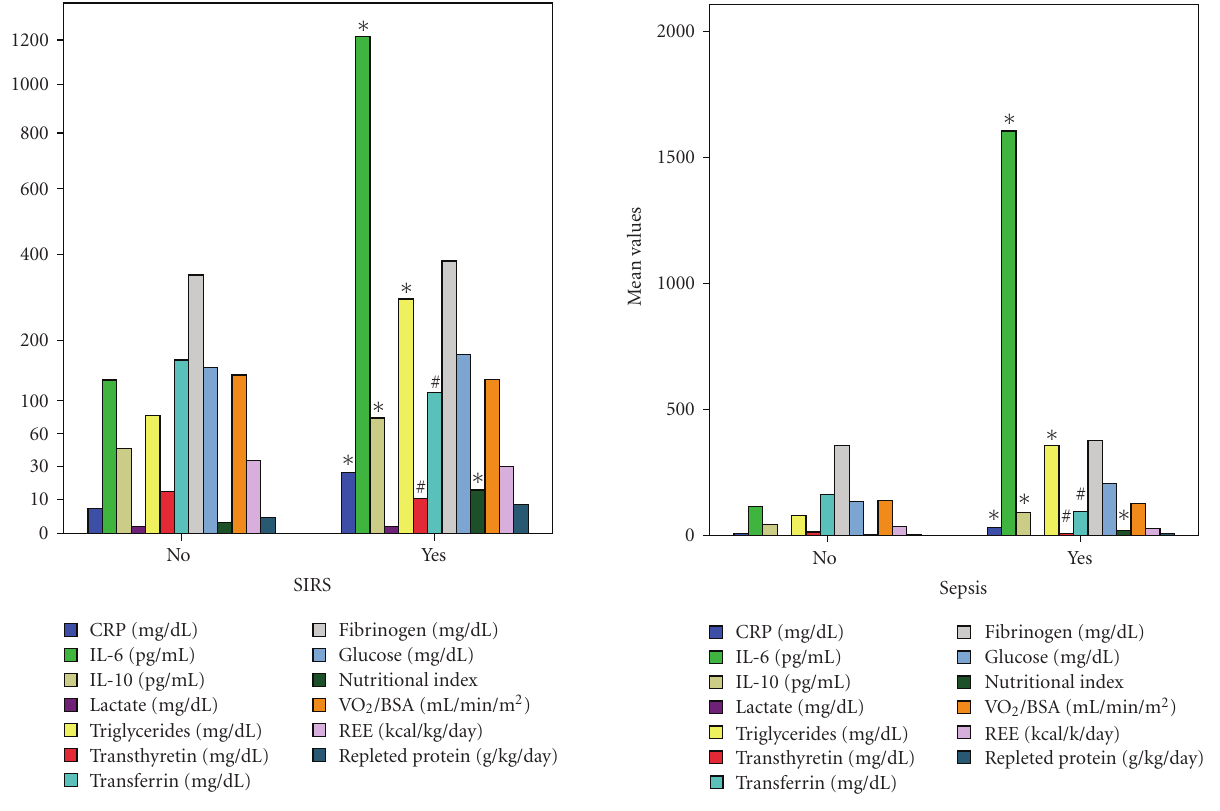
Figure 2: Comparison of metabolic monitor measurements, various cytokines, and nutritional markers between patients with and without sepsis (scale type power: exponent 0.5). Significantly increased ( ∗ ) in the presence of sepsis: C-Reactive Protein (CRP), Interleukin-6 (IL-6), Interleukin-10 (IL-10), nutritional index, and triglycerides ( t -test for unpaired data). Significantly decreased (#) despite a higher protein intake: transferrin and transthyretin. Did not di ff er compared to the nonsepsis patients: lactate, glucose, fibrinogen, Oxygen Consumption (VO 2 ), and Resting Energy Expenditure (REE). BSA: Body Surface